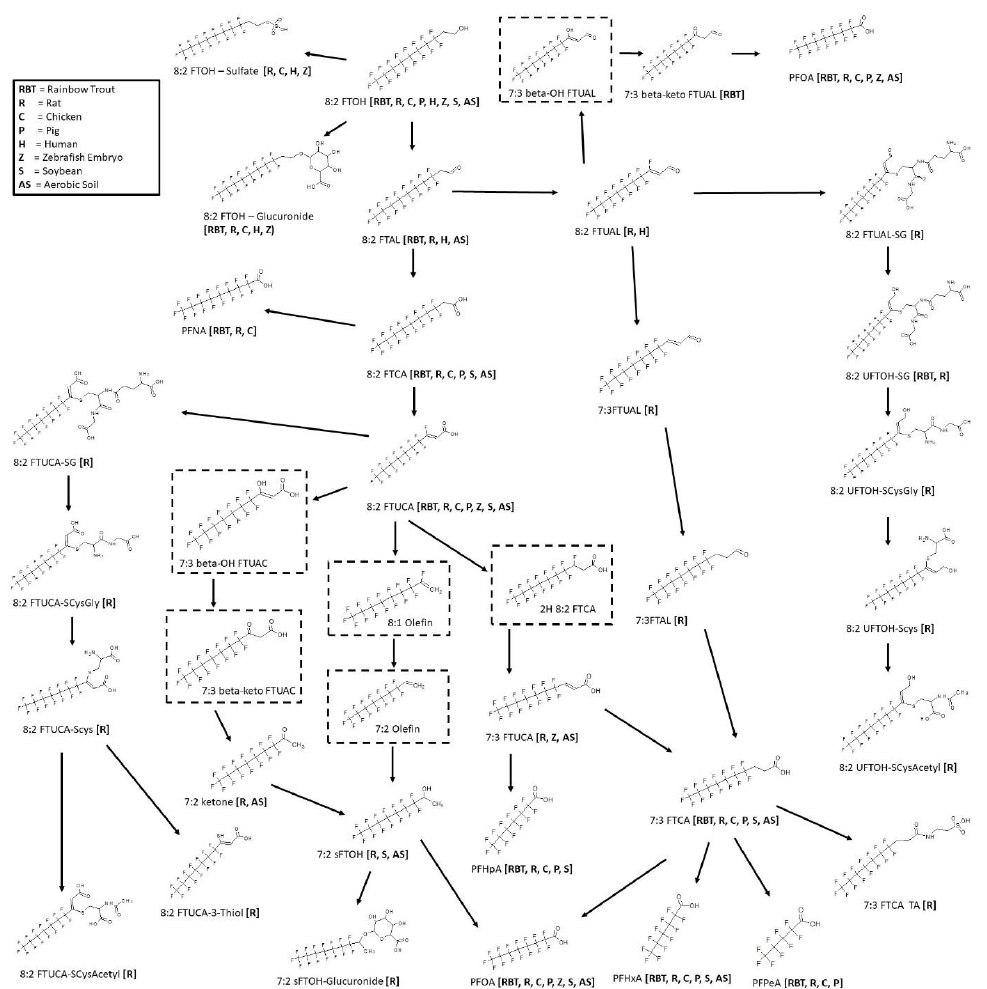
the 8:2 diPAP map (Figure 12), conjugates for 8:2 FTOH were reported as 8:2 FTOH-sulfate in rat, chicken, human, and zebrafish and 8:2 FTOH-glucuronide in rainbow trout, rat, chicken, human, zebrafish. The rainbow trout pathway goes through oxidation of 8:2 FTOH to the identified 8:2 fluorotelomer aldehyde (8:2 FTAL), the carboxylic acid (8:2 FTCA), and unsaturated acid (8:2 FTUCA). The 7:3 fluorotelomer carboxylic acid (7:3 FTCA) was also identified. The series of perfluoroalkyl carboxylic acids were found in rainbow trout: PFNA, PFOA, PFHpA, PFHxA, and PFPeA. Most of these terminal products were also found in rat, chicken, pig, zebrafish, and aerobic soil. The rat map contributed an extensive list of intermediates and various conjugates with glutathione, cysteinylglycine, cysteine, cysteineacetyl, thiol, and taurine.